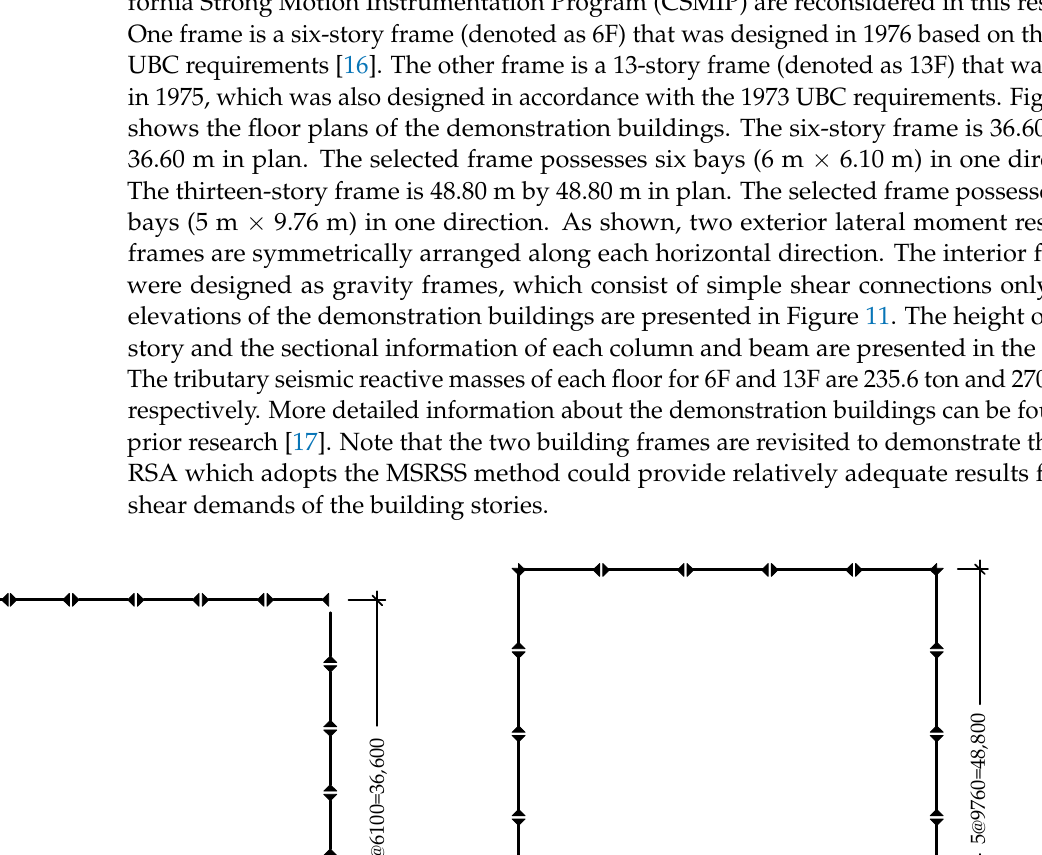
Figure 11. Elevation of the 6F and 13F buildings. 4.3. Computer Modeling and Seismic Excitations The systems shown in Figure 11 are numerically modelled in OpenSees to conduct the RHA [14]. Further, in order to validate the application scope of the method, one special case based on 13F is established as 13F-W, in which the bending stiffness of the beams and columns below the eighth floor are reduced by 50%. This case is supplemented to validate the application of the method in the structures with an irregular stiffness distribution along the building’s height. All of the frame members are modelled using the displacement-based beam-column elements. The sectional parameters are consistent with those of prior research to achieve the same dynamic features. Since the method is proposed for linearly elastic shear struc- tures, the material nonlinearity of the systems is not considered in the OpenSees model. Thus, all of the elements are modelled with an elastic material. It should be noted that the elastic modulus of steel in the 6F model is increased by 18% to achieve the same periods, as recommended in prior research [17]. As proposed in prior research, the Raleigh damp- ing model of 3% is used for the two models. A leaning column pinned to the ground is included in the model to capture the P- ∆ effect of the system. The leaning columns are modeled using the truss element with tremendous axial stiffness. The tributary gravity loads are applied to the leaning column on the floor levels. Additionally, a rigid dia- phragm is adopted in this model.